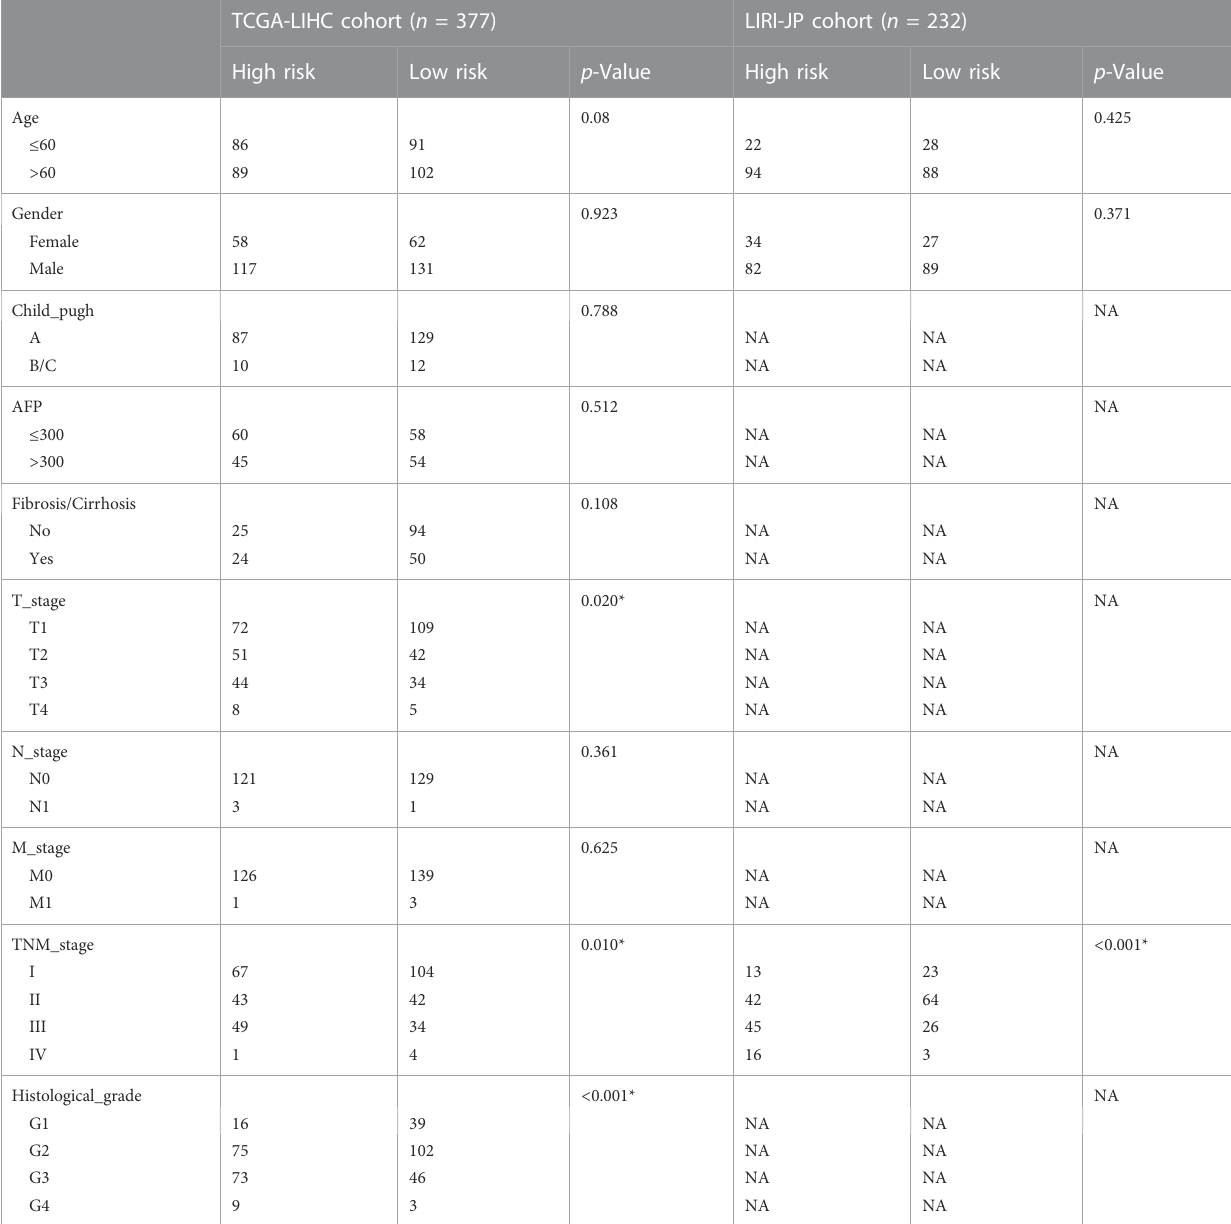
TABLE 1 The correlation between risk score and clinicopathological features of HCC patients in the TCGA and ICGC